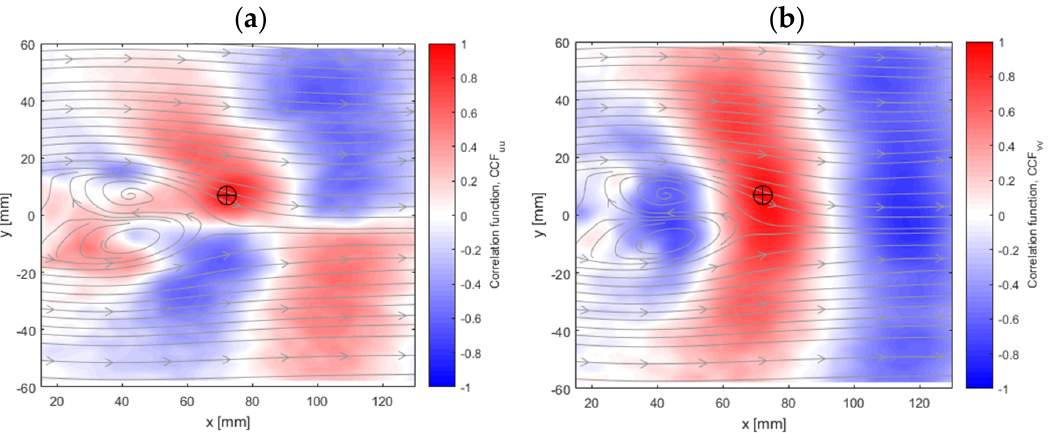
Figure 5. ( a ) u-component and ( b ) v-component cross-correlation functions about point VP 1 . Ensemble average velocity streamlines overlaid for reference.